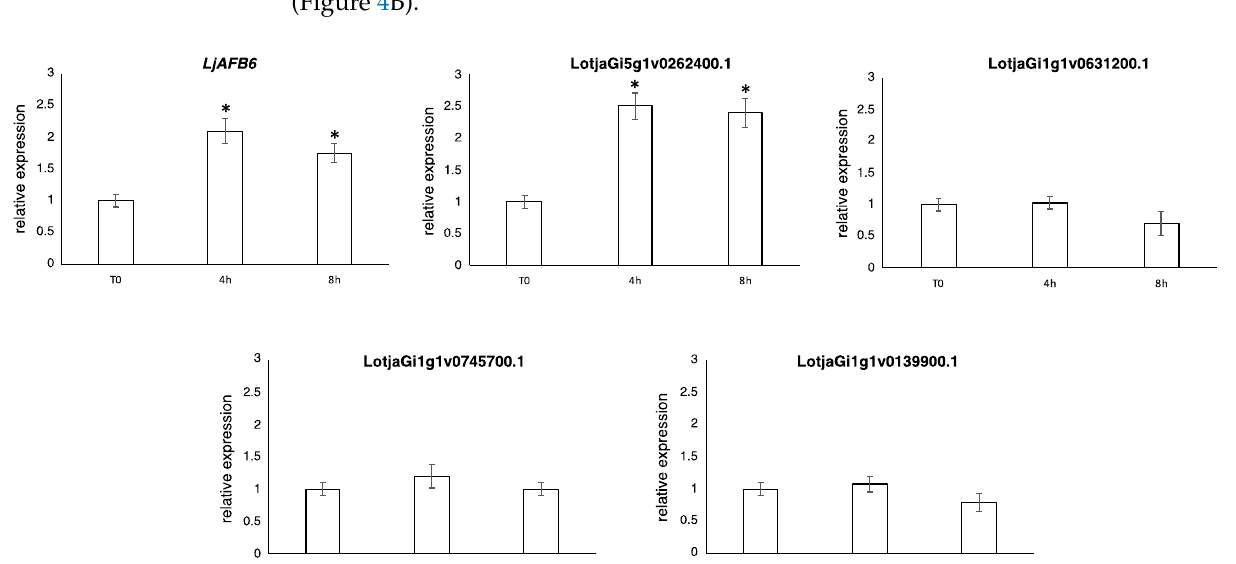
Figure 3. Nitrate dependent expression of the LjTIR1/AFB genes. RNAs were extracted from roots of wild-type plants grown for 10 days on Gamborg B5 derivative medium with glutamine 1 mM as the sole nitrogen source and transferred on 1 mM KNO 3 for the indicated range of times. Expression levels are normalized with respect to the internal control UBIQUITIN (UBI) gene and plotted relative to the expression of T0. Data bars represent means and SD of data obtained with RNA extracted from three different sets of plants and three qRT-PCR experiments. Asterisks indicate significant differences with T0 levels. * p < 0.01.